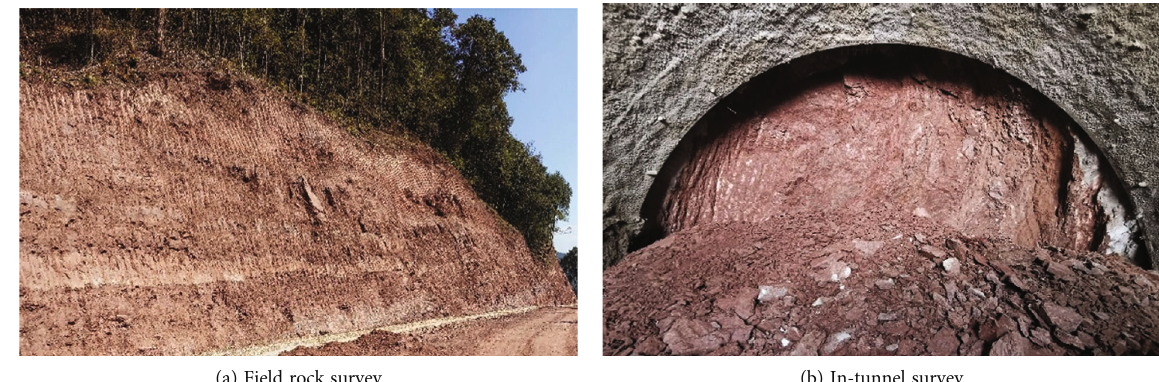
Figure 6: All-mudstone-type stratigraphic